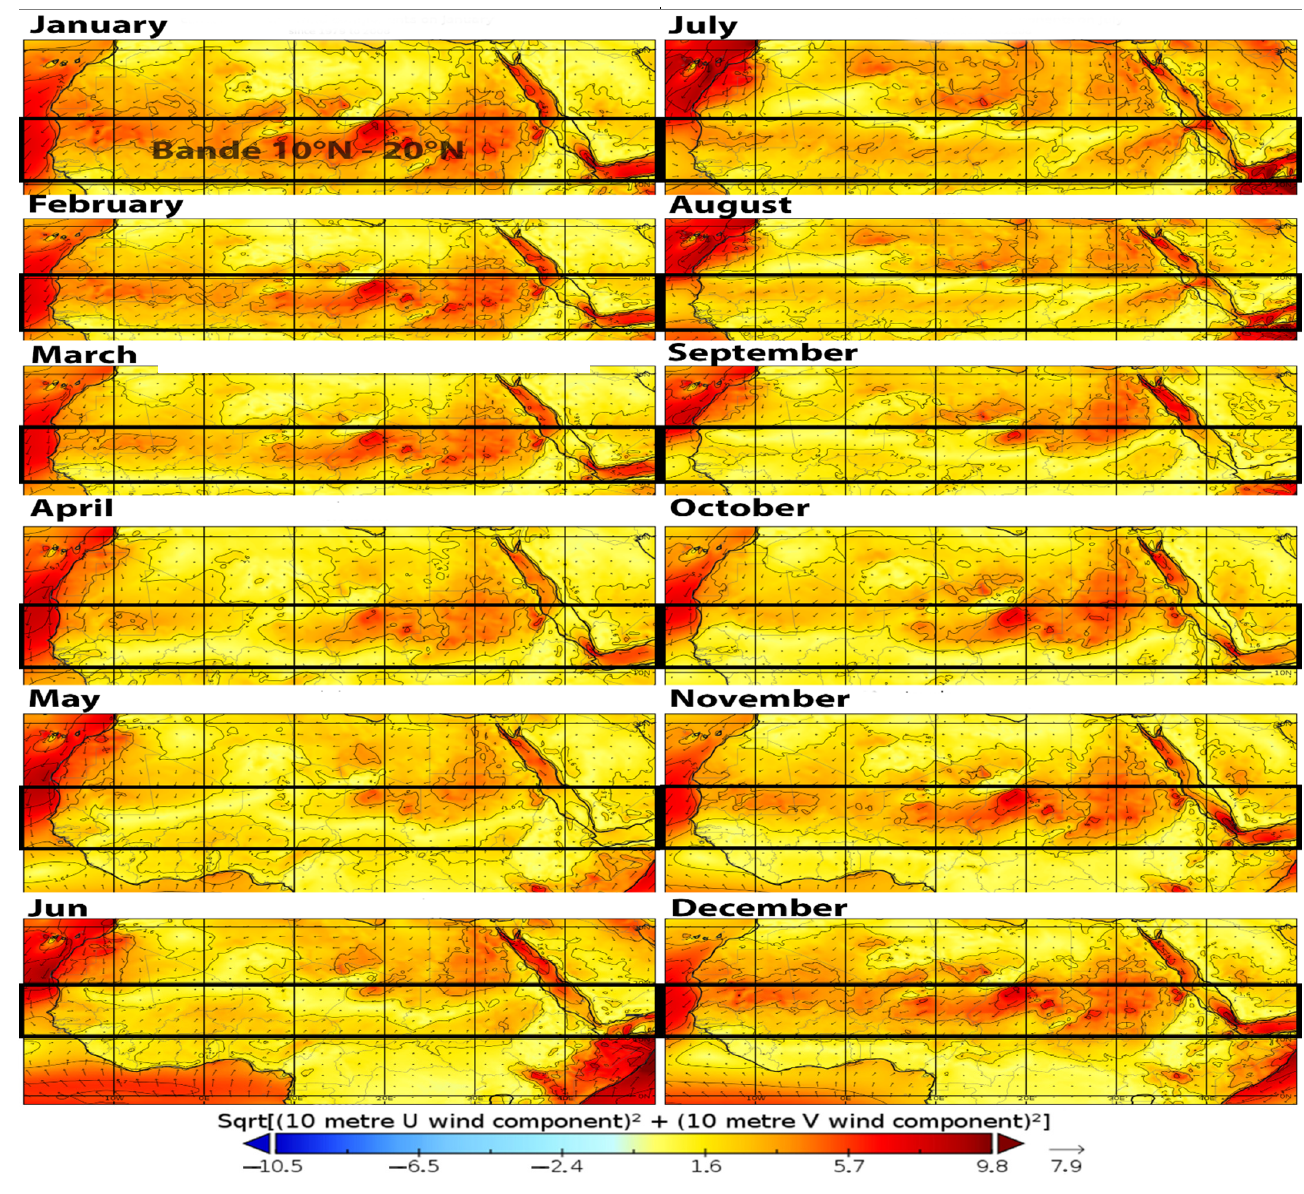
Figure 1. Monthly average wind climatology at 10 from 1979 to 2008 (4D-Var ERA5) m s − 1 with a resolution of 0.5 × 0.5 degrees data from the ERA5 platform.